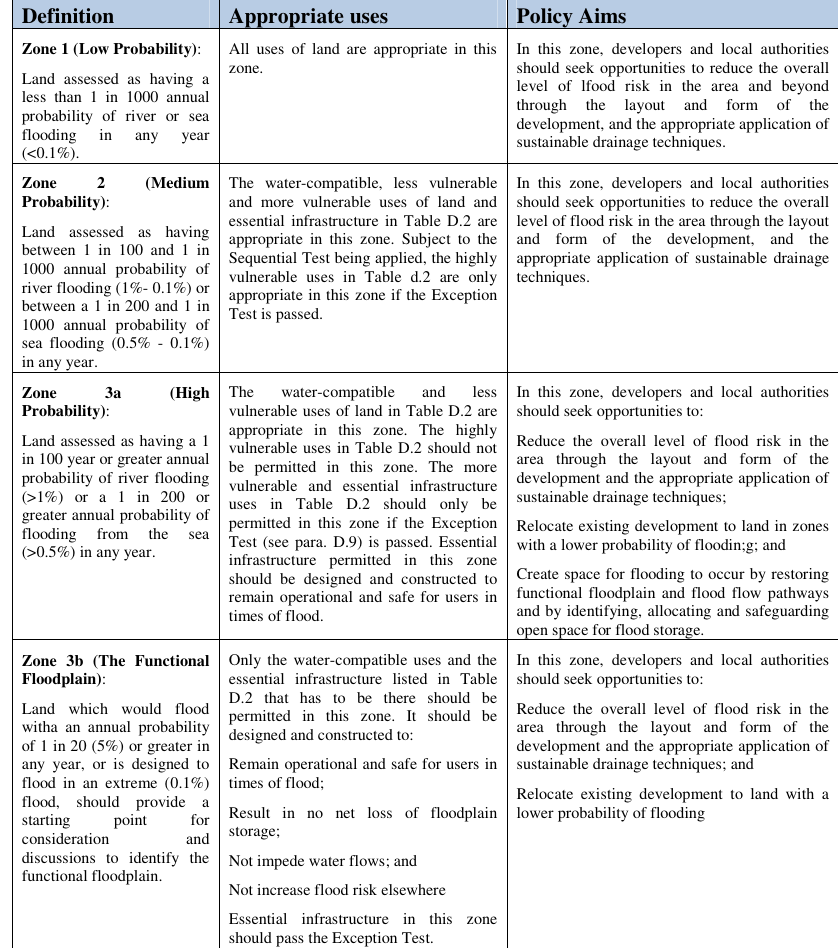
Fig. 1. The Sequential Test (from PPS 25, Table